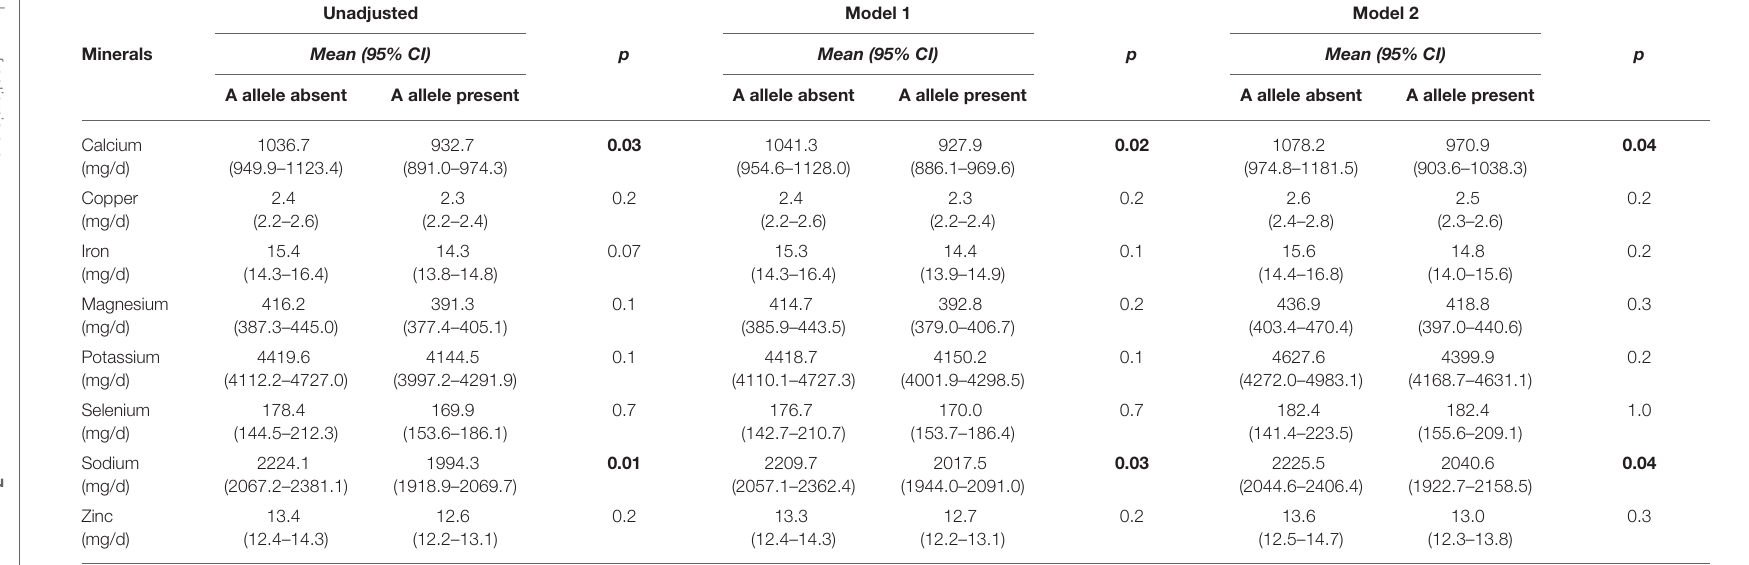
TABLE 3 | Estimated dietary mineral intakes vary by the presence of the KCNJ2 -A allele in unadjusted and adjusted models. Unadjusted Model